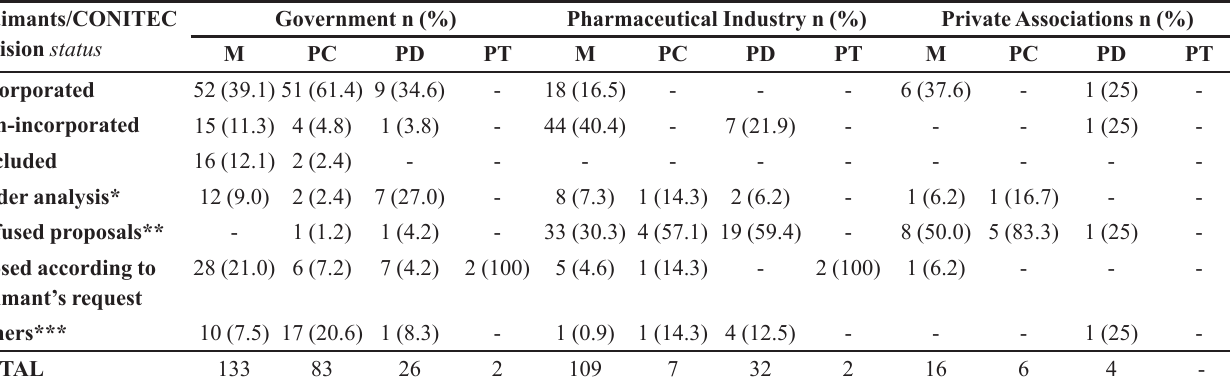
TABLE II - Request claimant distribution and status of the National Committee on Technology Incorporation (CONITEC), according to types of technology. January 2012 - July 2015,